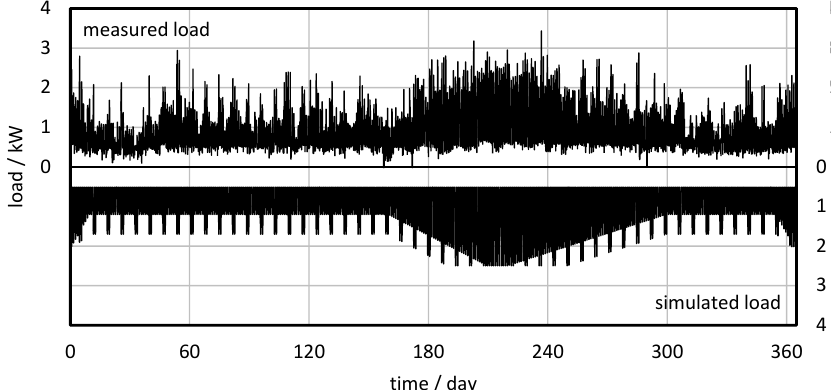
Figure 8. Comparison of the measured and simulated loads.